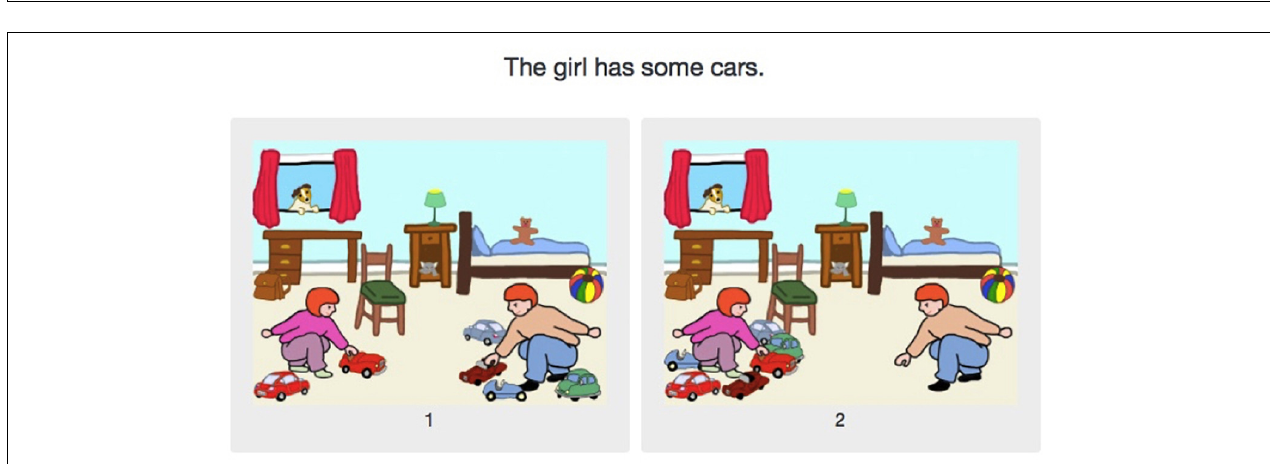
FIGURE 8 | Experiment 2: The some condition (pragmatic answer on the left, semantic answer on the right).